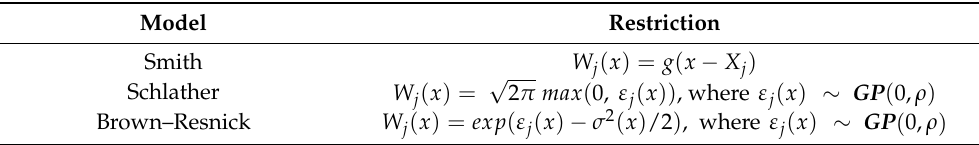
Table 1. Max-stable models and corresponding restrictions on stochastic function. GP denotes a Gaussian